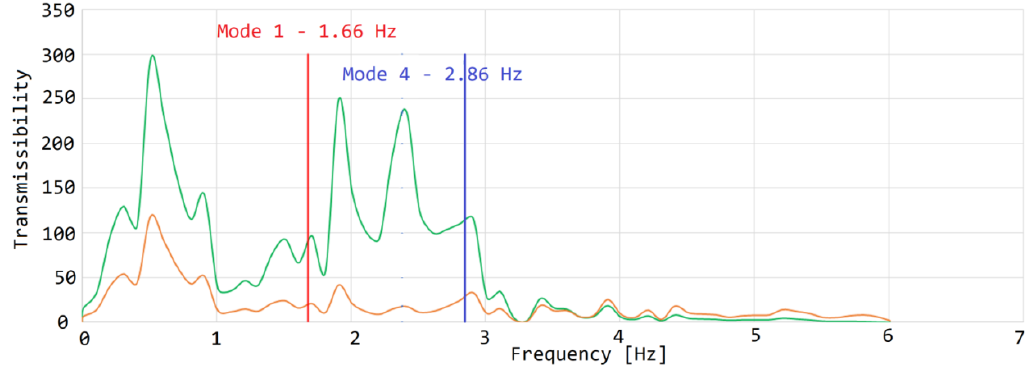
Figure 14. The response of the system subjected to excitations in the Z direction.